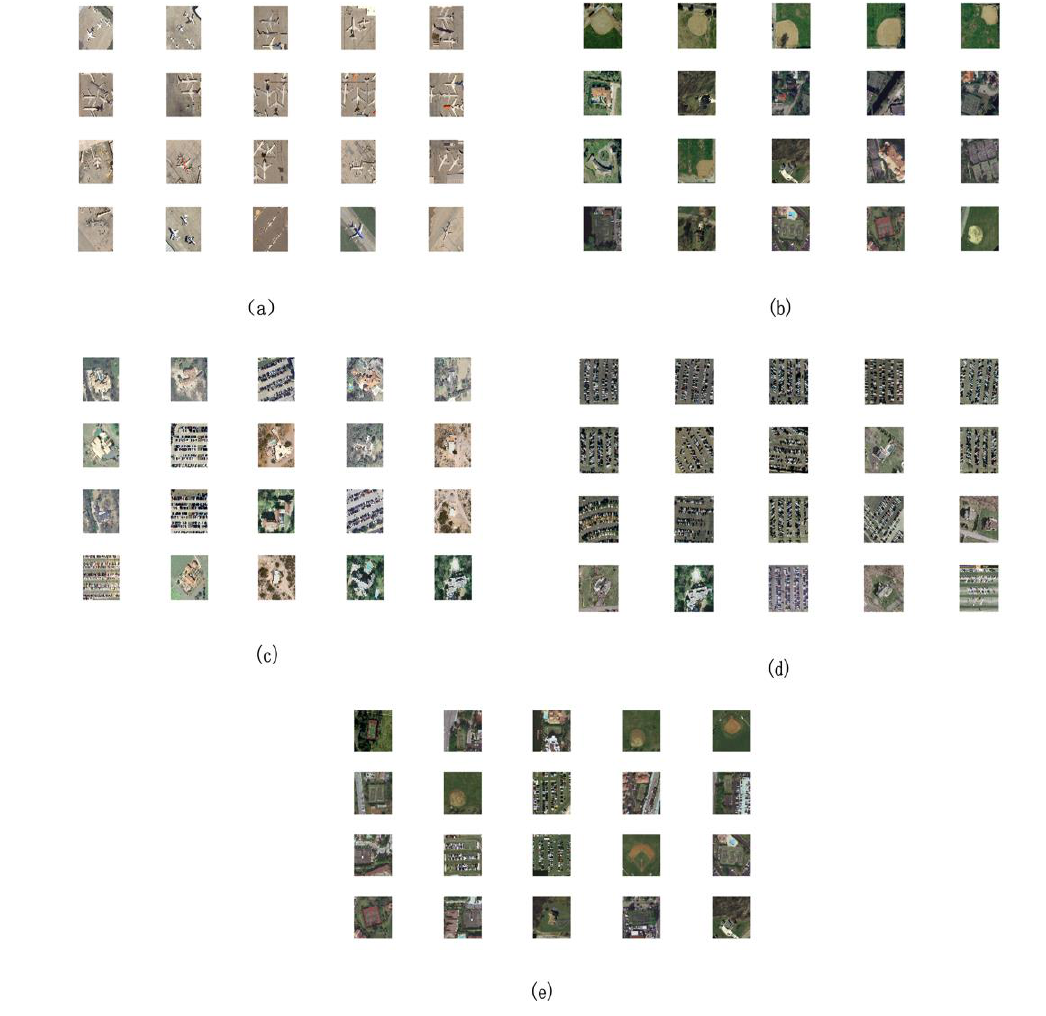
Figure6. Examples of 5 class images retrieval based on combined